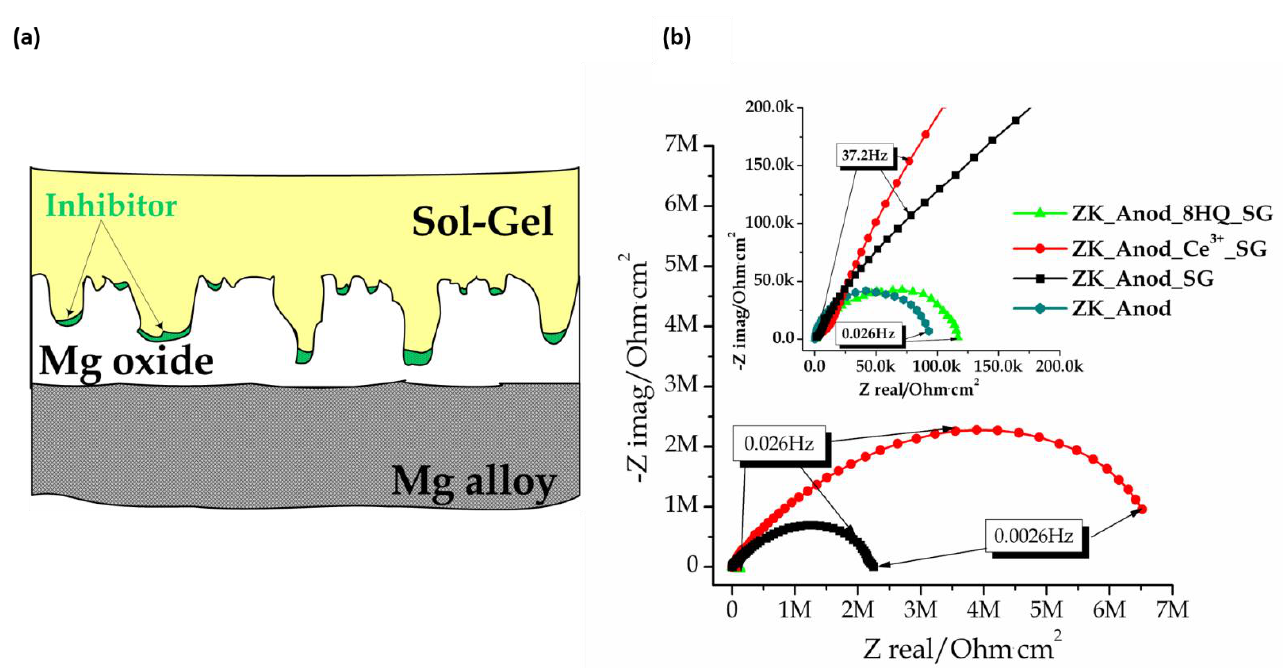
Figure 22. ( a ) Schematic representation of the composite protective coating comprising the highly porous anodized or PEO layer enriched with corrosion inhibitors and sealed with the organic coating; ( b ) Nyquist plots of corresponding ZK30 Mg alloy samples enriched with Ce 3+ or 8HQ after 2 weeks in 0.05 M NaCl solution. Adapted from [100] with permission from